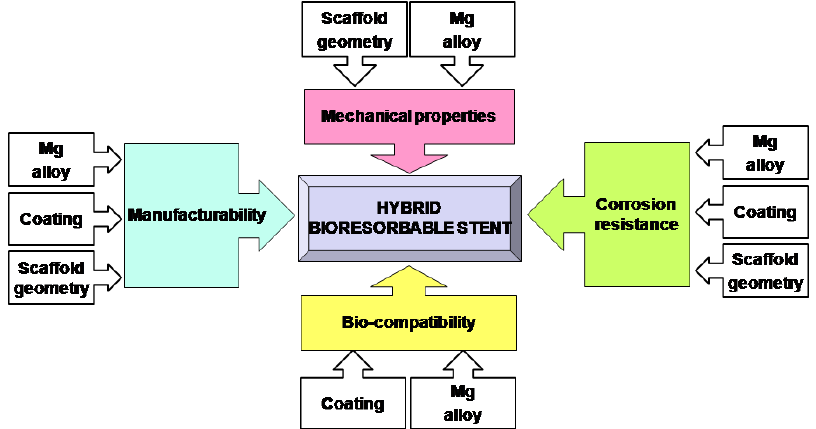
Figure 1: Scheme of the multidisciplinary approach used to develop a hybrid bioresorbable stent, made of a magnesium alloy coated with a